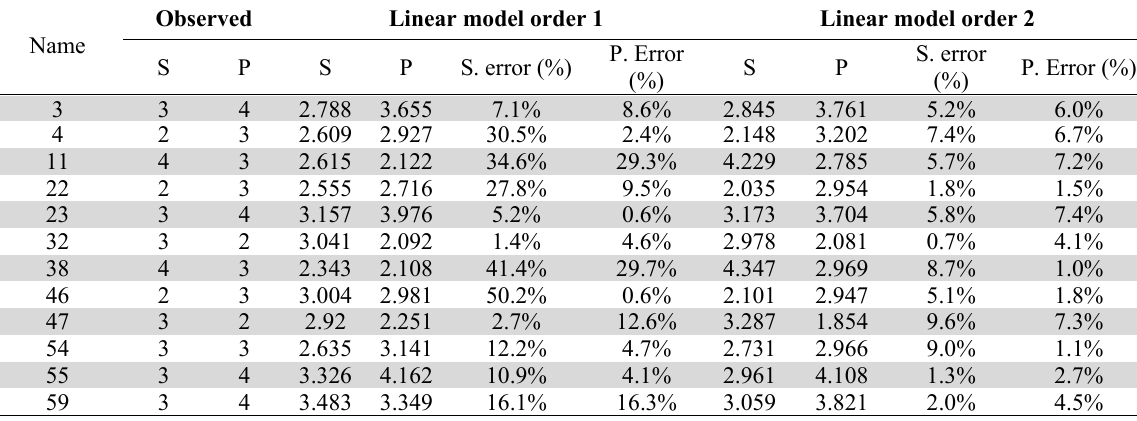
Neural network model